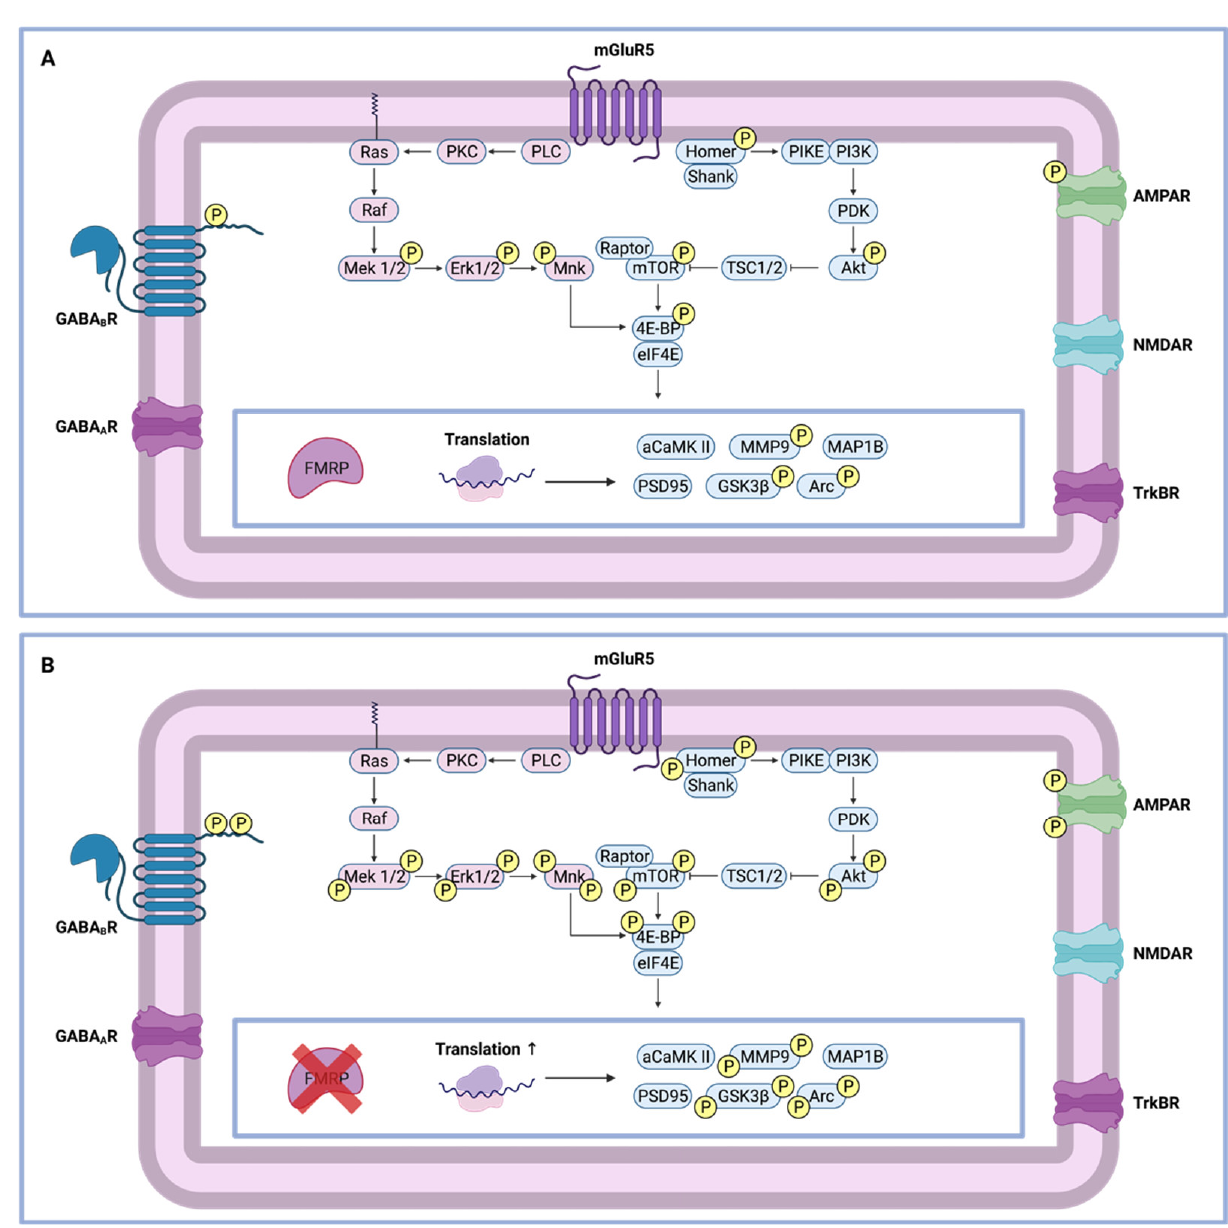
Figure 2. Schematic overview of the molecular signaling pathways in the FXS. ( A ) In physiological conditions, the glutamatergic pathway is activated upon binding of glutamate to the mGluR5 which is located on the postsynaptic cell membrane. A network of protein kinases and phosphatases, with their downstream signaling targets, either becomes activated or inhibited due to phosphorylation, thus regulating the activity of FMRP. Phosphorylation of FMRP results in the release of the bound mRNAs, causing protein translation. ( B ) Loss of FMRP causes a broad-range kinomic deregulation which results in a stronger phosphorylation of several protein kinase substrates, e.g., the GABAergic pathway is affected by loss of FMRP, because it stabilizes mRNAs of several subunits of the GABA A receptor. Loss of FMRP also causes translational imbalance with an increased synthesis of proteins such as Calcium/Calmodulin Dependent Protein Kinase II Alpha ( α CaMKII), Matrix Metallopeptidase 9 (MMP9), Microtubule Associated Protein 1B (MAP1B), postsynaptic density protein 95 (PSD95), Glycogen Synthase Kinase 3 Beta (GSK β ), and Activity Regulated Cytoskeleton Associated Protein